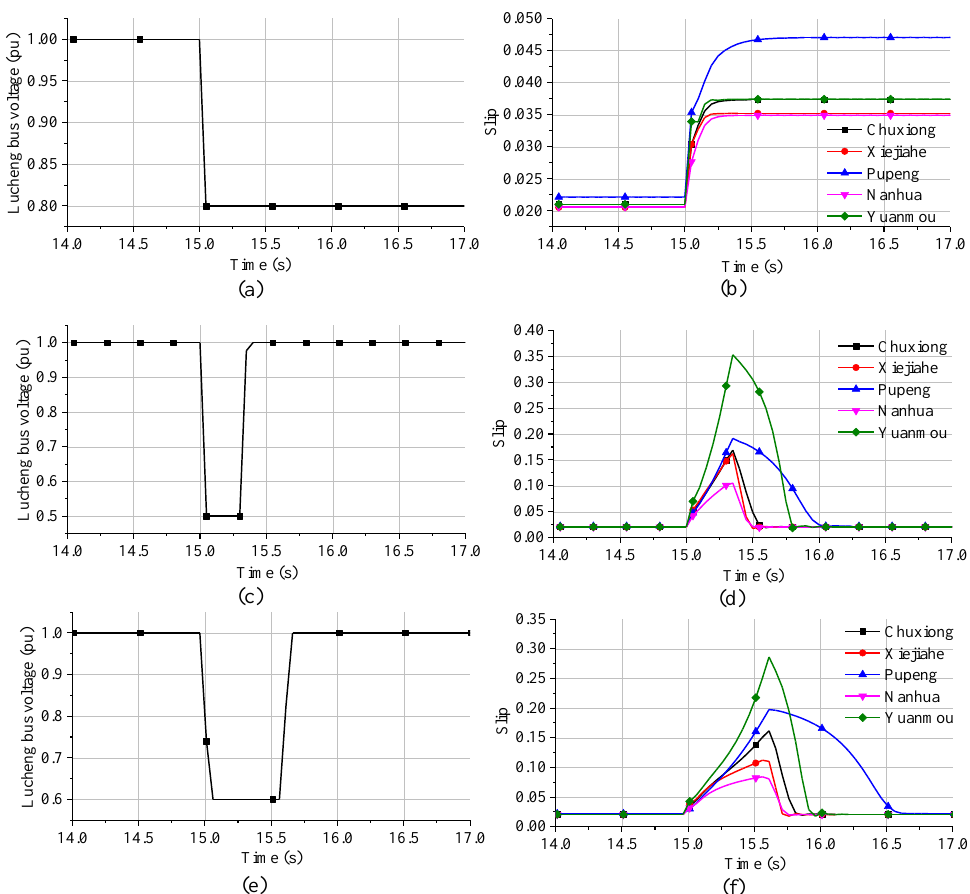
Figure 8. Simulation results to verify the WSCC practical criterion: ( a ) Lucheng bus voltage curve (condition 1), ( b ) motor slip curves (condition 1); ( c ) Lucheng bus voltage curve (condition 2); ( d ) motor slip curves (condition 2); ( e ) Lucheng bus voltage curve (condition 3); ( f ) motor slip curves (condition 3).